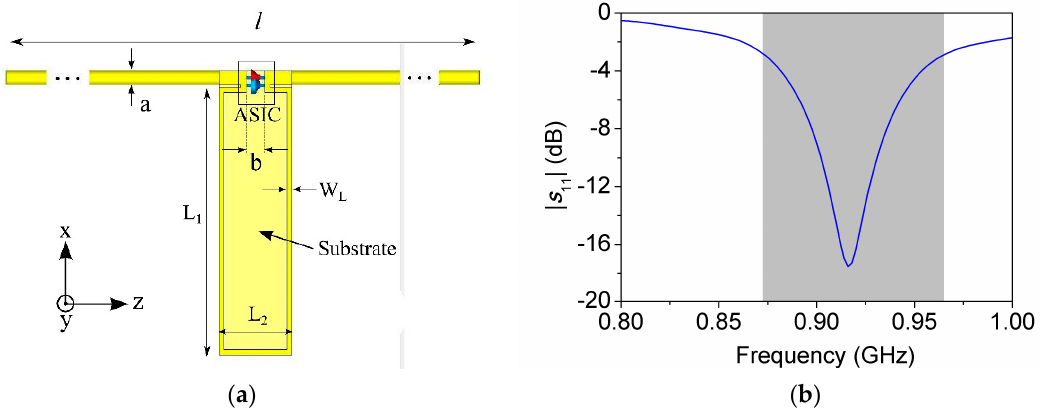
Figure 4 . ( a ) Final tag layout; ( b ) Simulated power reflection coefficient (half-power bandwidth in grey).